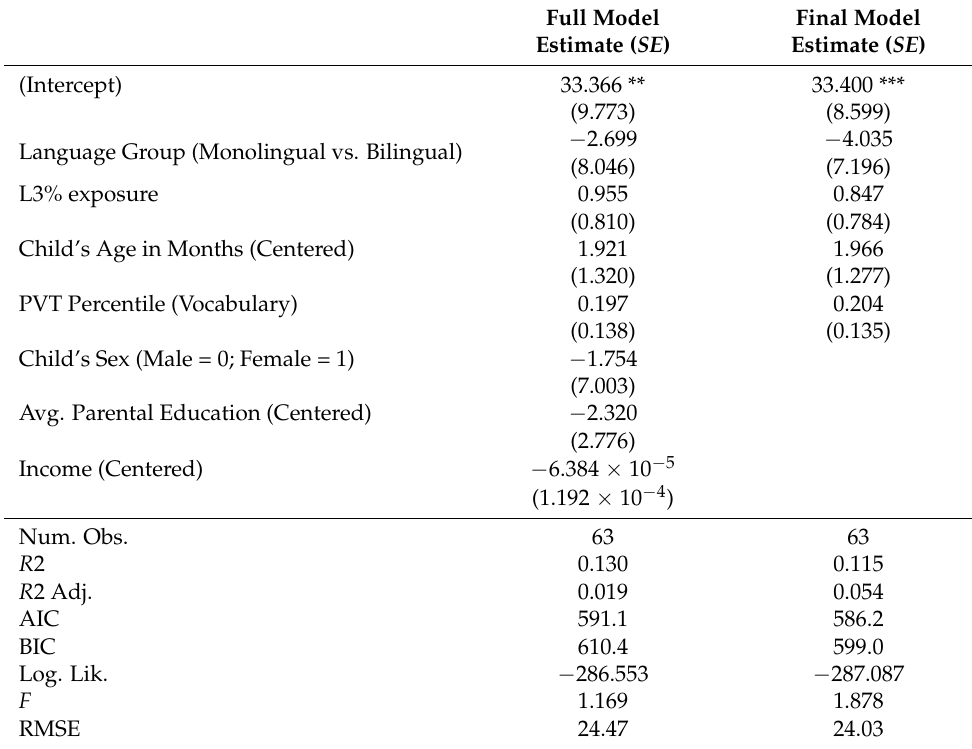
Table 3. Linear Regression Models for Analysis Approach 1-Monolinguals vs. Bilinguals.